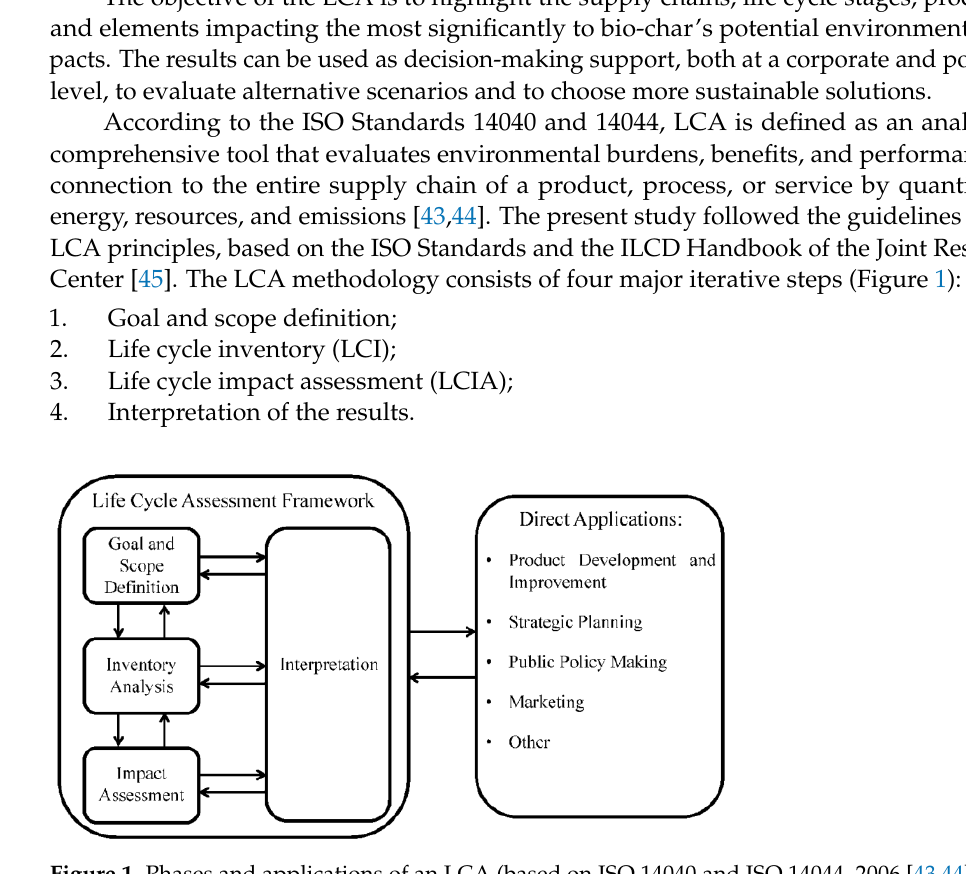
Figure 1. Phases and applications of an LCA (based on ISO 14040 and ISO 14044, 2006 [43,44]).